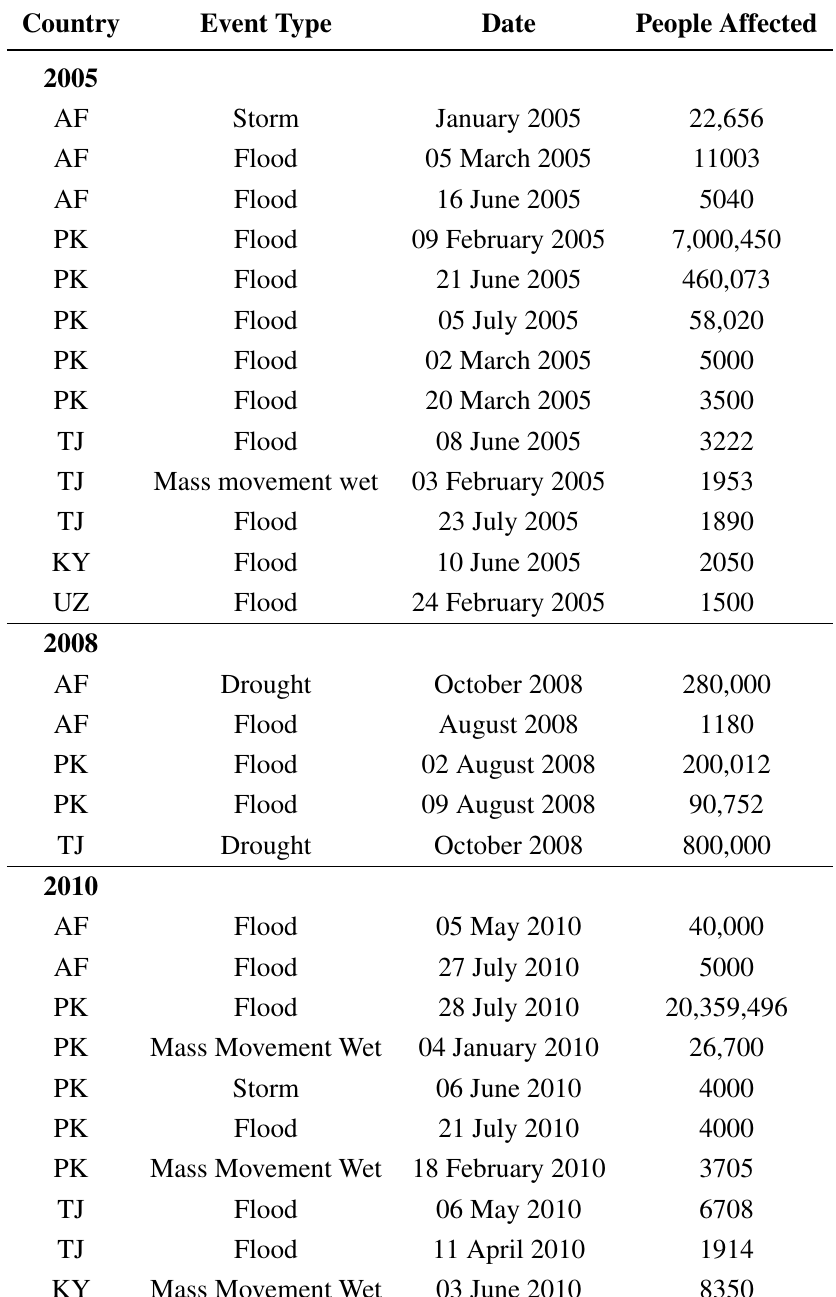
Table 1. Selected hazard events from Emergency Events Database (EM-DAT) [53] in the greater Pamir region and adjacent regions for the years 2005, 2008 and 2010. Events are listed according to affected country, rather than exact